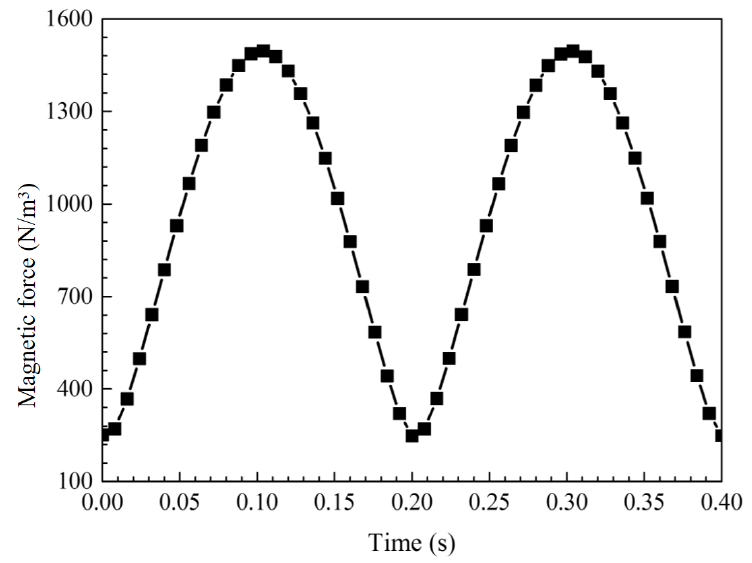
Figure 5. The magnetic force monitored on the center plane of the stirrer, on the half radius of the round bloom.